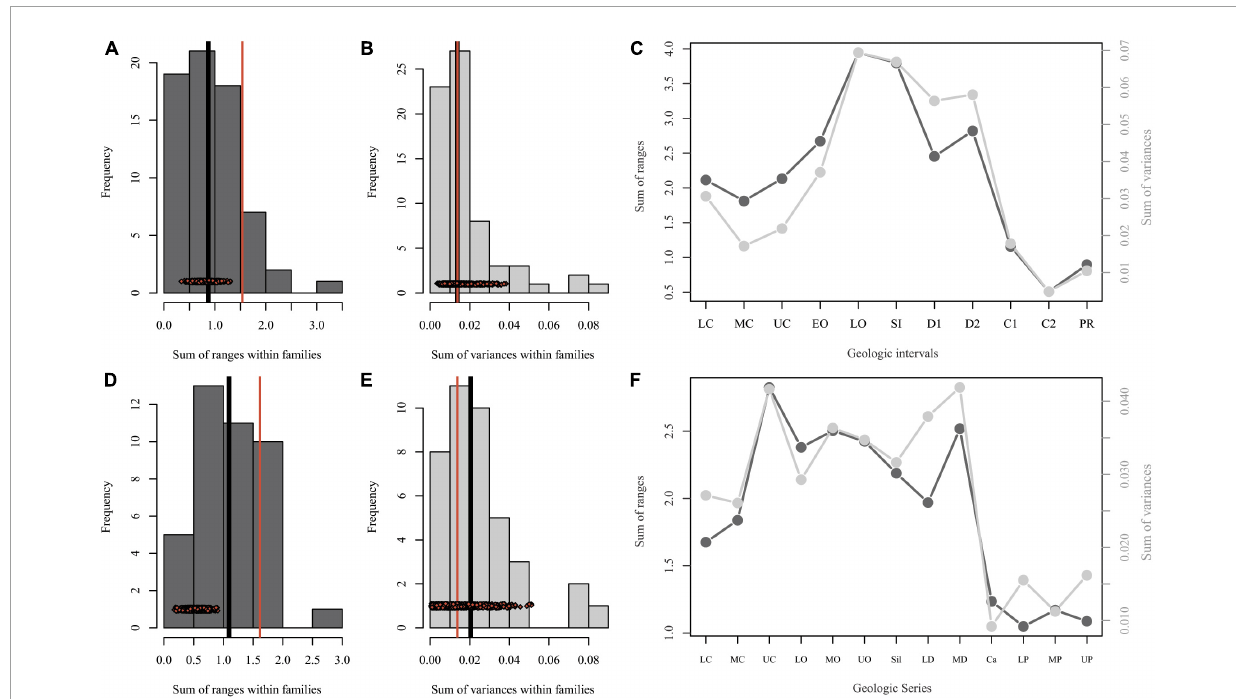
FIGURE1 Disparity within trilobite head shape, represented either by Fourier analysis of the outline of the cranidium (medial sclerite of the head shield) (A–C) or by Procrustes superimposition of semi-landmark data describing the cephalon (entire head shield). (D–F) Disparity is estimated using sum of ranges, which describes overall breadth of morphospace occupation, and sum of variances, which describes the density of points within the space occupied (Hopkins and Gerber, 2017; Guillerme et al., 2020). (A,D) Disparity (sum of ranges) within families; black line shows median and red line shows disparity for Proetidae. Red diamonds show disparity estimates for Proetidae when subsampled to median sample size within families. (B,E) Disparity (sum of variances) within families; black line shows median and red line shows disparity for Proetidae. Red diamonds show disparity estimates for Proetidae when subsampled to median sample size within families. (C,F) Disparity (sum of ranges in dark gray; sum of variances in light gray) through time. Cranidial dataset (A–C) modified from Foote (1993); cephalic dataset (D–F) modified from Suárez and Esteve (2021); see Supplementary materials for details. C1 = early Carboniferous; C2 = late Carboniferous; Ca = Carboniferous; D1 = early Devonian; D2 = later Devonian; EO = early Ordovician; LC = lower Cambrian; LO = late Ordovician; LP = lower Permian; MC = middle Cambrian; MO = middle Ordovician; MP = middle Permian; PR = Permian; SL = Sil = Silurian; UC = upper Cambrian; UO = upper Ordovician; UP = upper